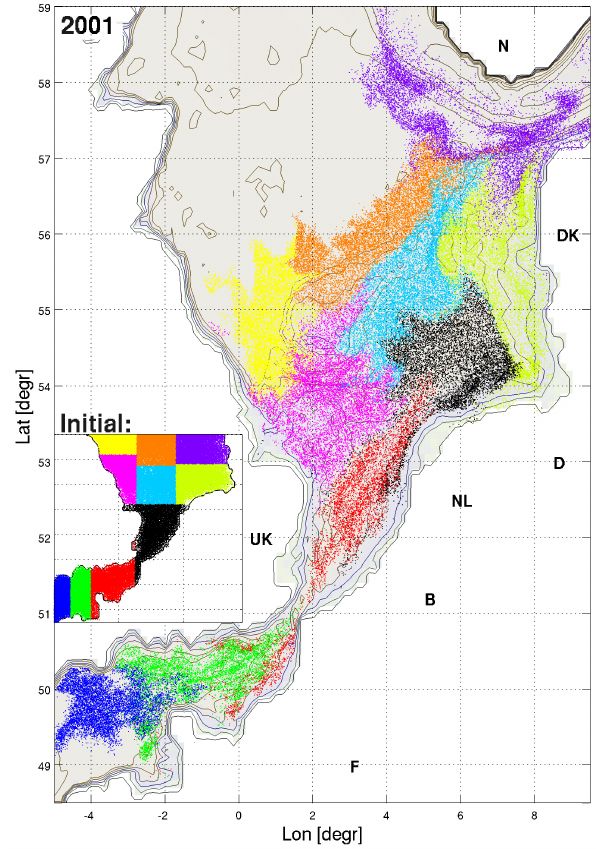
Figure 5. Distribution of particles at the end of their pelagic life span (up to 120 days). Only shown are particles that do not settle and to improve clarity only 100000 particles that were released around 1 January are included. The colour of the dots corresponds to the release location of the particles, which is shown in the